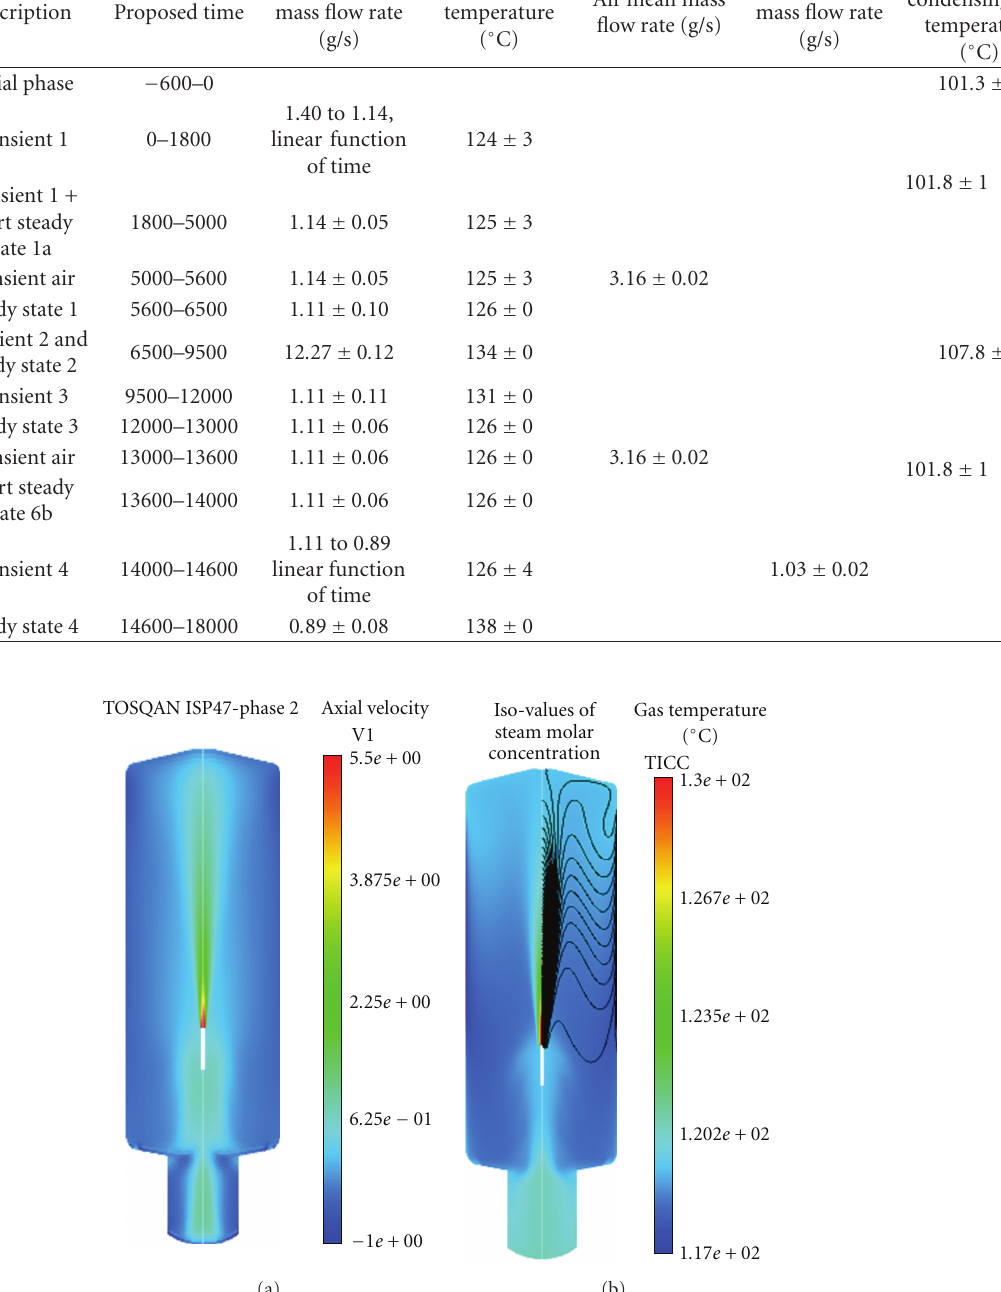
The mean upper (resp., lower) noncondensing wall tem- perature is maintained constant and equal to 122.0 ◦ C ± 1 (resp., 123.5 ◦ C ± 1) during the whole